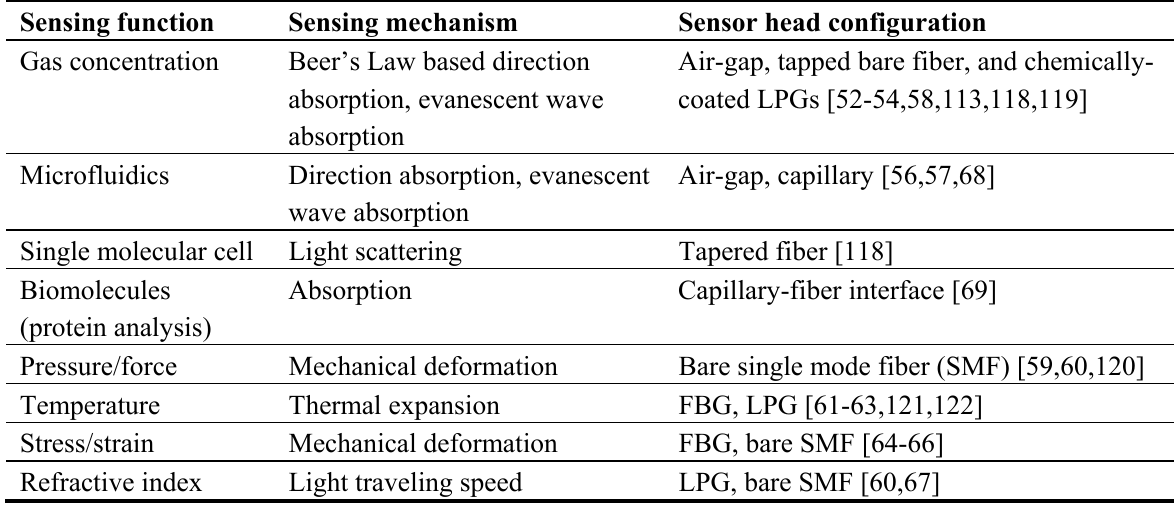
Table 3. Reported FLRD-based